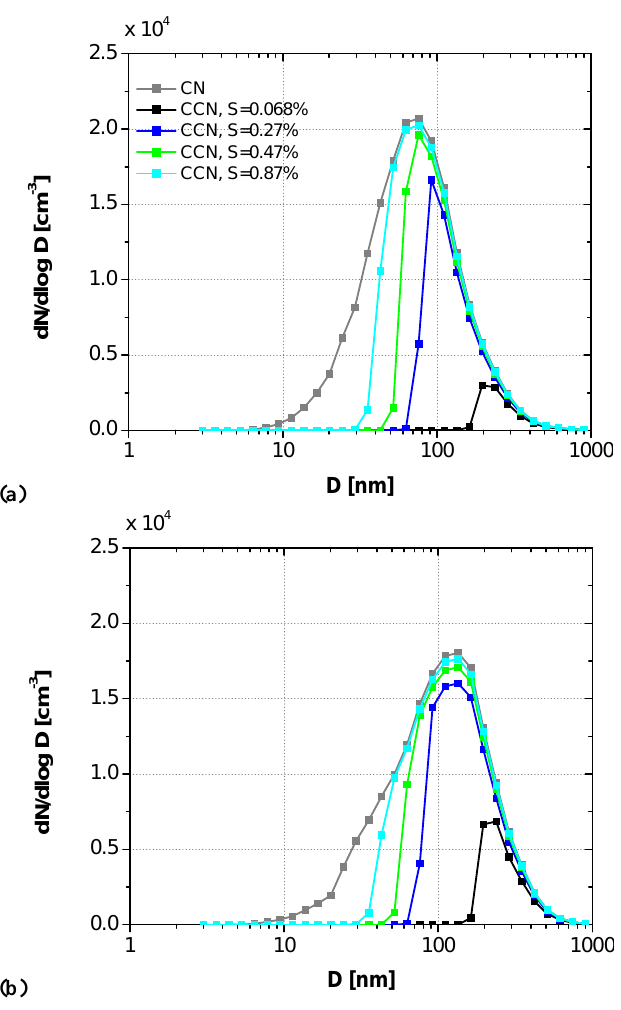
Fig. 7. Number size distributions of total aerosol particles (CN) and Cloud Condensation Nuclei (CCN) averaged over (a) the entire campaign and (b) the biomass burning event. The CCN size distri- butions were calculated by multiplying the median CN size distribu- tion with the median CCN efficiency spectra from Fig. 3. For clarity and to avoid potential biases due to different averaging times, CCN size distributions are displayed only for the supersaturation levels covered throughout the campaign.